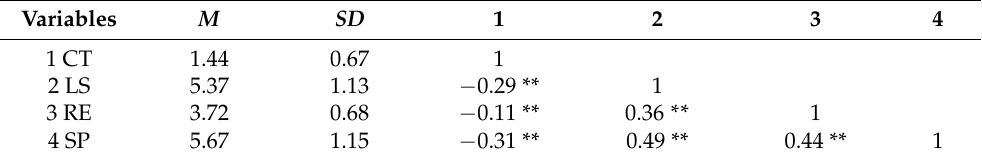
Table 2. Means, standard deviations, and correlations between study